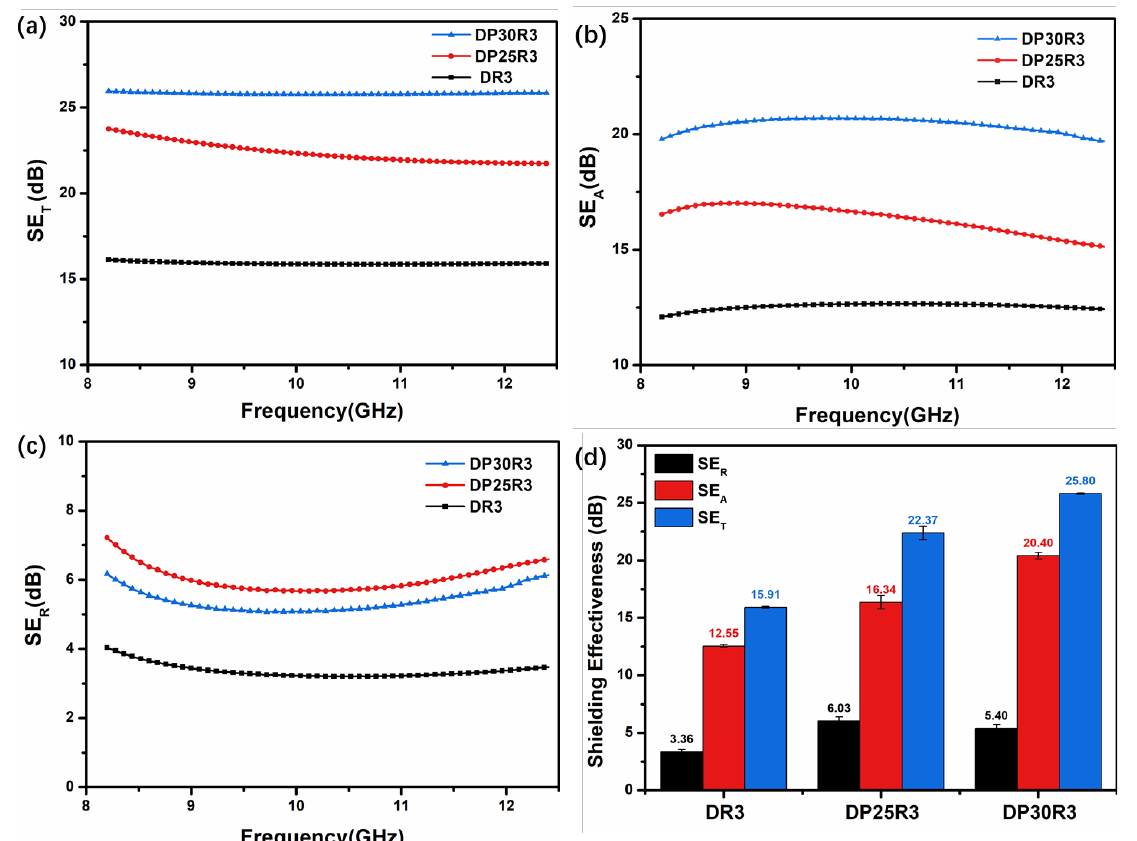
Figure 9. The EMI shielding effectiveness of DR3, DP25R3, and DP30R3 in the 8.2–12.4 GHz frequency range, ( a ) SE T , ( b ) SE A , ( c ) SE R , and ( d ) the average SE T , SE A , and SE R in the X band.